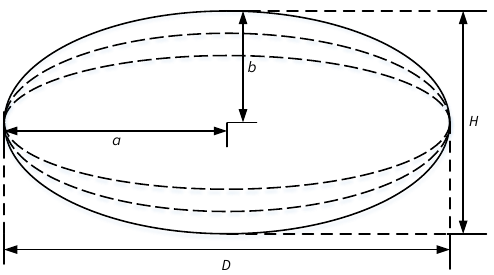
Figure 2. The schematic diagram of simplified AUH’s profile used for its height determination.